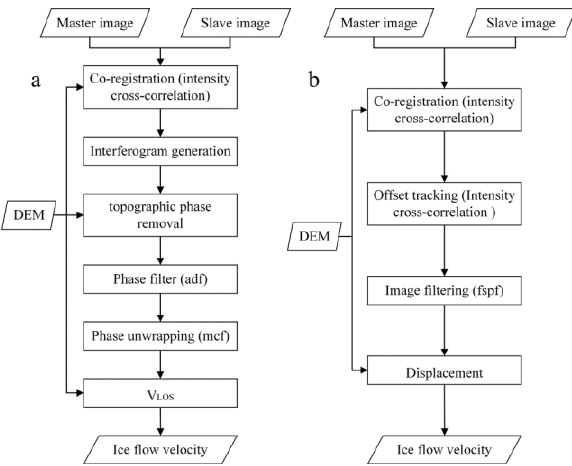
Figure 2 . Technical flow charts of DInSAR (a) and offset tracking (b) employed in this